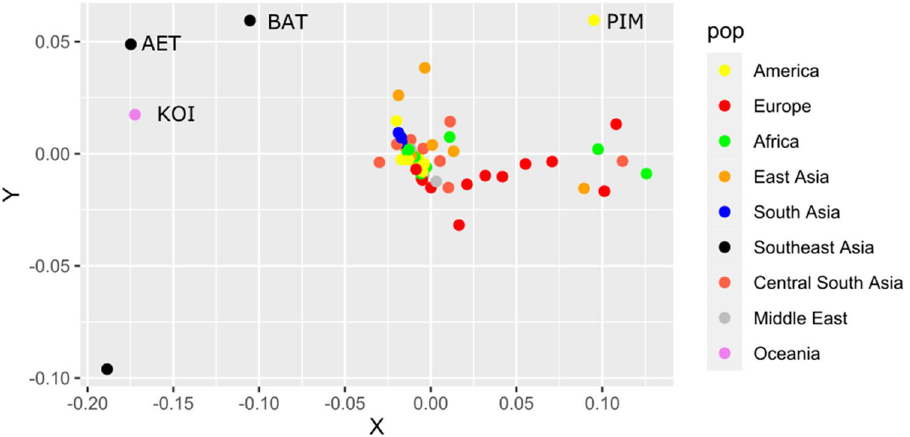
Figure 3. Multidimensional scaling (MDS) illustrating the distance (measured by F ST estimated from HLA- G SNPs) among population samples with at least 10 individuals. The name of each population is available at Table S1. We have indicated the names of some outliers.